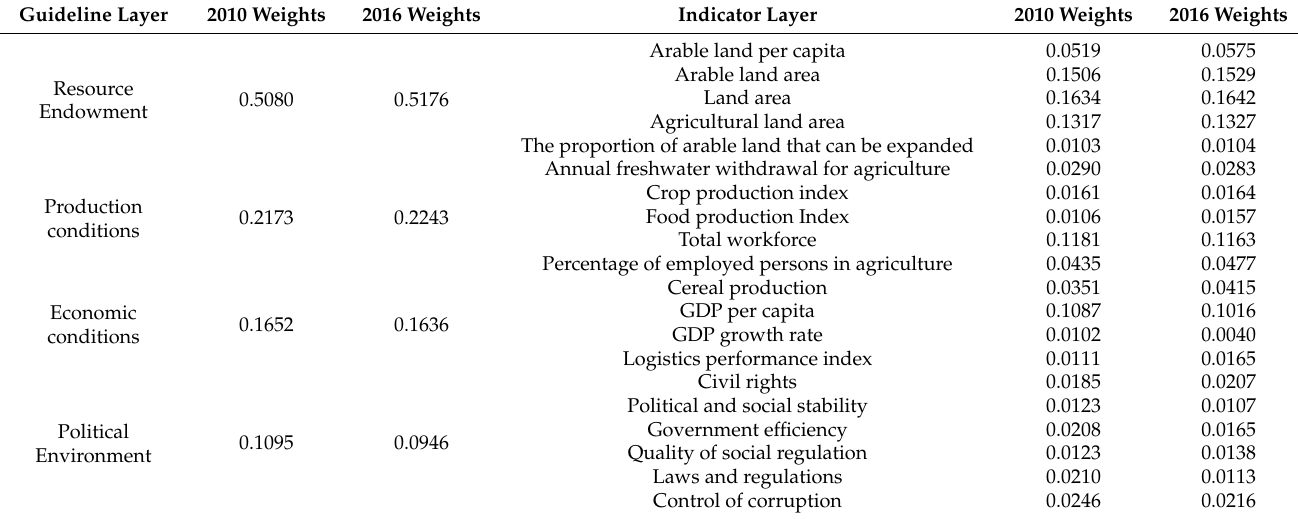
Table 4. Weight of each index of arable land investment potential within “the belt and road initiative countries”. Guideline Layer 2010